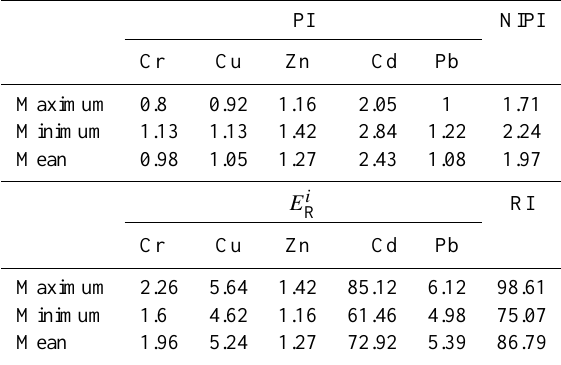
Table 3. Statistical results of pollution index (PI), Nemerow inte- grated pollution index (NIPI), potential ecological risk index of a single element ( E i ) and comprehensive potential ecological risk R index